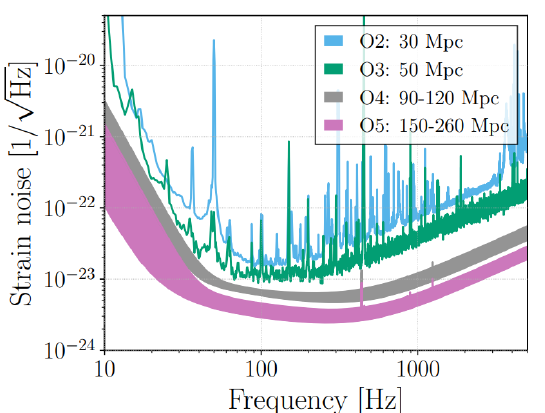
Figure 1. Advanced Virgo and Advanced Virgo+ sensitivities from O2 to O5 observation runs, taken from Figure 1 in [10]. The O2 and O3 sensitivity is shown while O4 and O5 give possible ranges depending on outcomes of current studies.